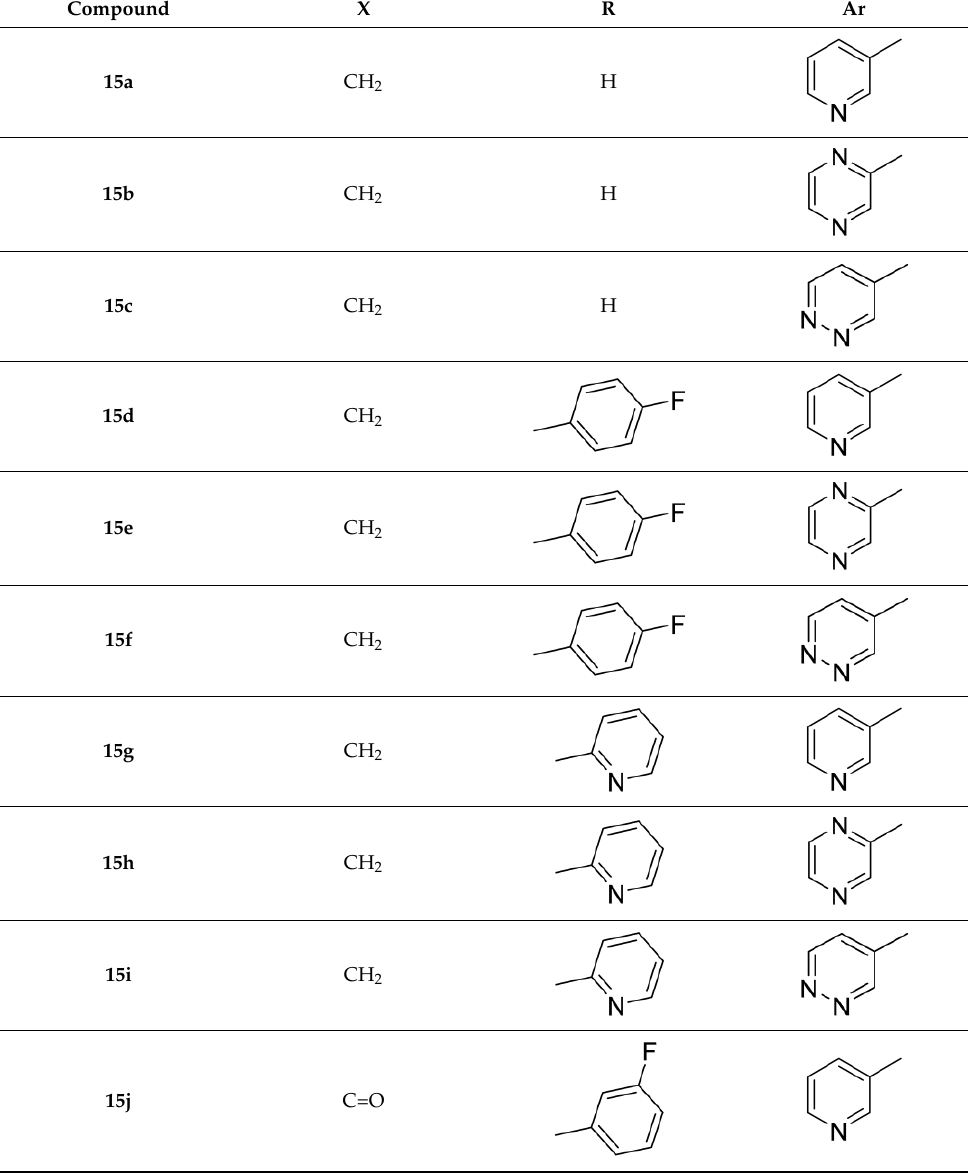
Table 1. Key structure of compounds 15a–l .